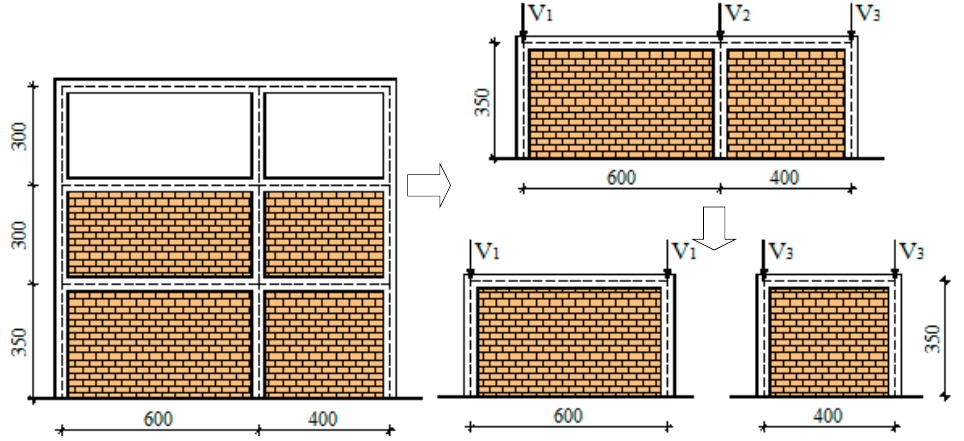
Figure 13. Approximation model for multi-storey multi-bay infilled frame Patras.